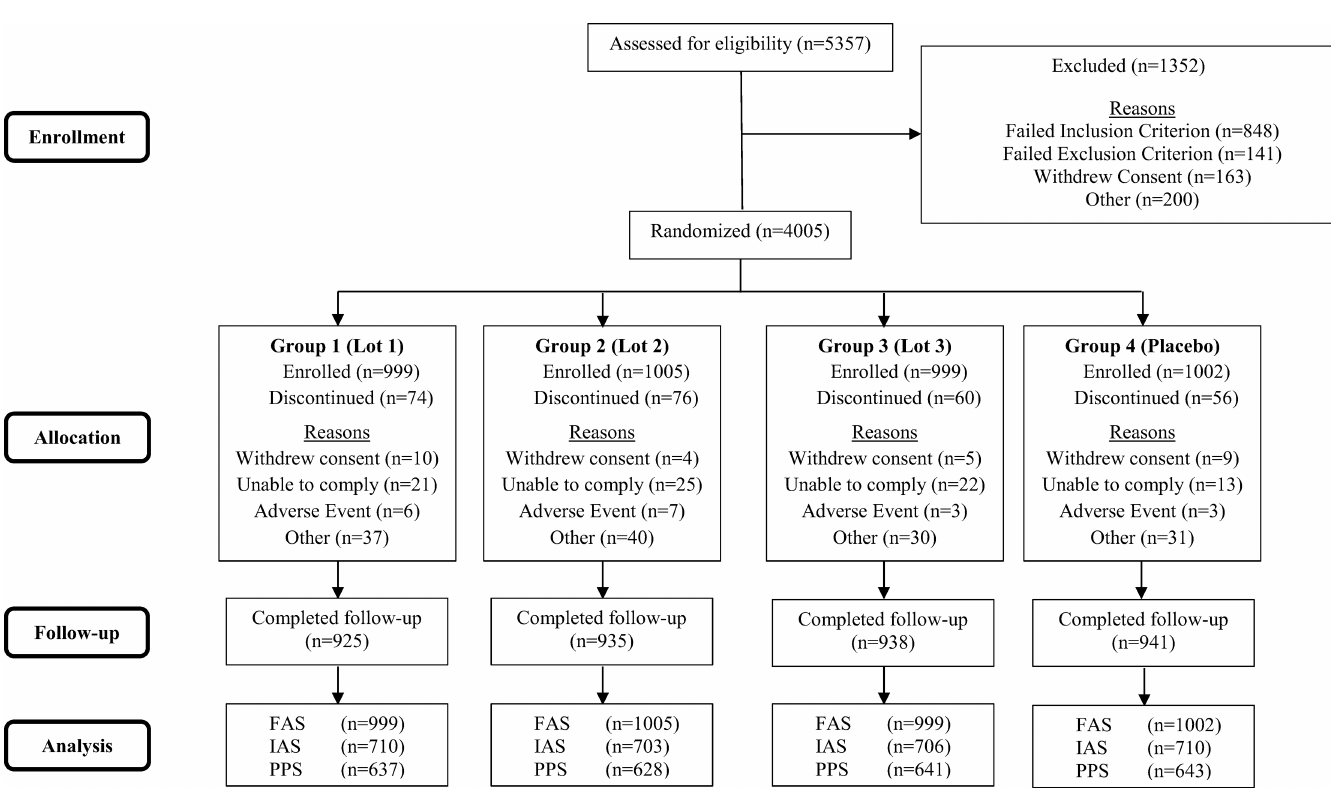
Fig 1. Subject disposition. FAS = full analysis set; IAS = Immunogenicity Analysis Set, subset used for immunogenicity analysis (first ~ 700 subjects enrolled per group); PPS = per protocol set; n = number of subjects in the specified category.